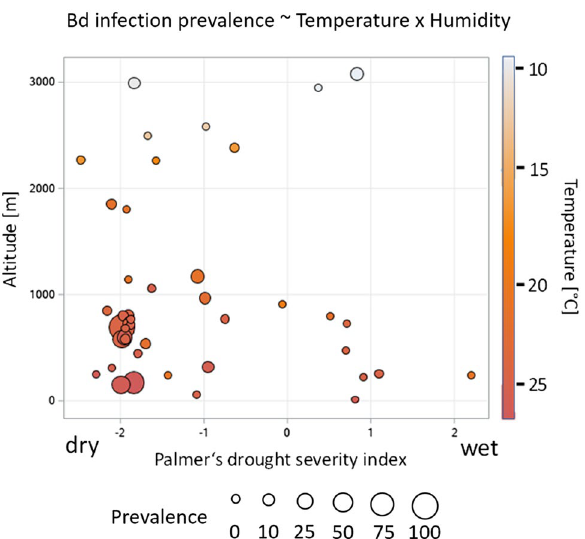
Figure 1. Bd -prevalence (%, bubble size, continuous) as a function of elevation, Palmers Drought Severity Index (PDSI), and yearly maximum temperature (T max ; bubble